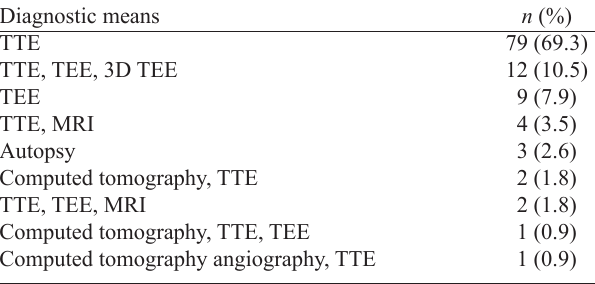
Table 9. Diagnostic means of cardiac myxoma.